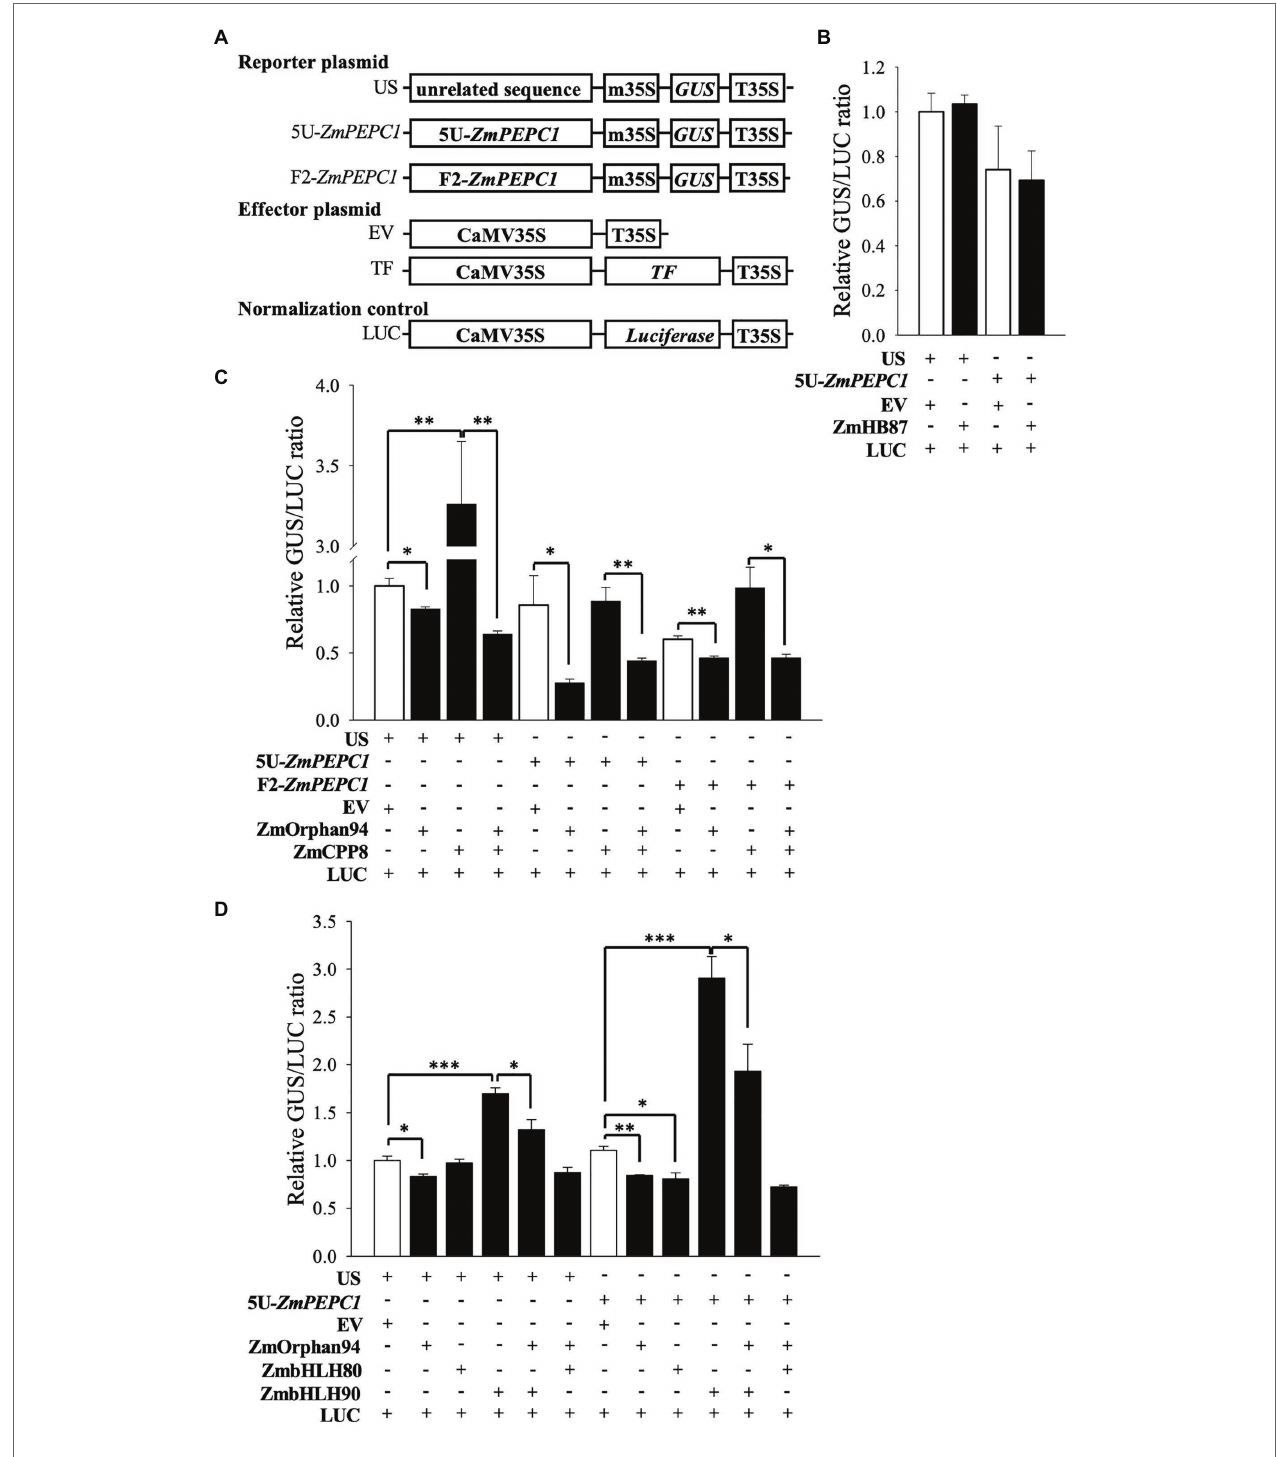
FIGURE 3 | Trans-activation assays to test the activity of the novel TFs. (A) Schematic representation of the constructs used in trans-activation assays in maize mesophyll protoplasts. T35S, cauliflower mosaic virus 35S terminator; EV, empty vector; m35S, minimal cauliflower mosaic virus 35S promoter; CaMV35S, full cauliflower mosaic virus 35S promoter; GUS, β -glucuronidase ; LUC, luciferase ; US, reporter vector harboring an Unrelated Sequence; 5 U -ZmPEPC1 and F2 - ZmPEPC1 , reporter vectors harboring the ZmPEPC1 upstream region fragments (5 U and F2, respectively) used in Y1H screening. Trans-activation activity of ZmHB87 (B) , ZmCPP8 and ZmOrphan94 individually and co-transformed (C) , and ZmOrphan94 individually and co-transformed with ZmbHLH80 or ZmbHLH90 (D) represented as a GUS/LUC ratio. Data represent means ± SEM ( n = 3). Differences are statistically significant ( t -test, * p < 0.05; ** p < 0.01; and *** p <